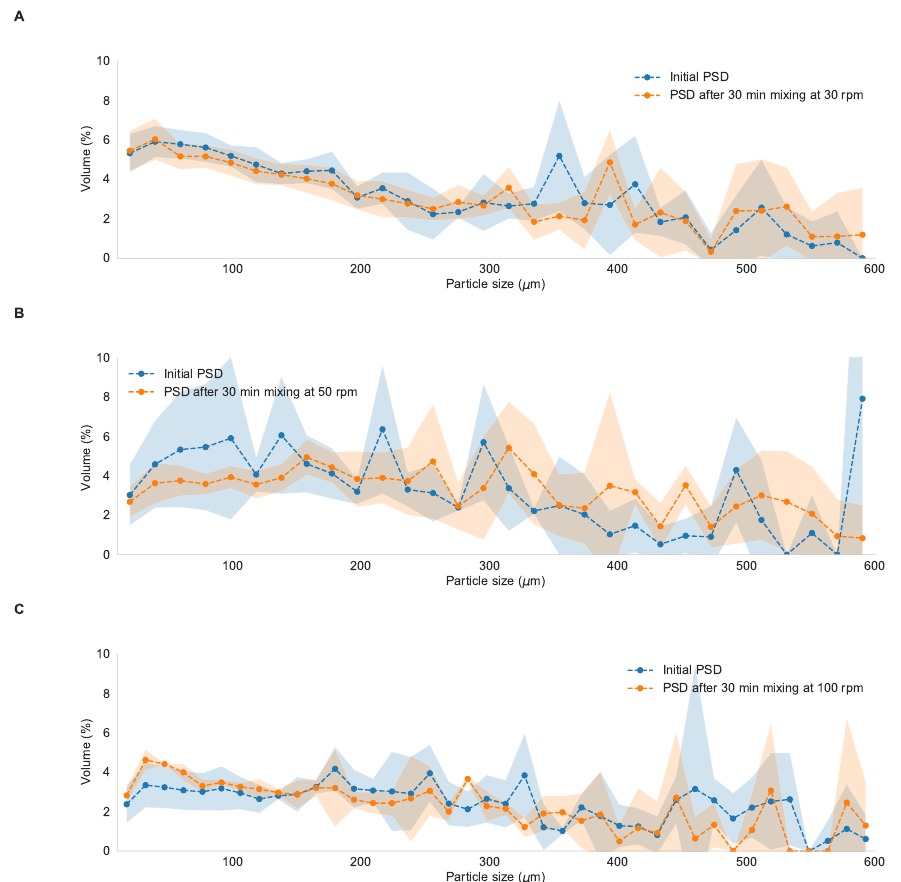
Figure A1. Volume based (in %) particle size distributions (PSDs) of the sludge measured before and after 30 min of mixing (radial mixer) in a square jar, for different mixer speeds: ( A ) 30 rpm, ( B ) 50 rpm, and ( C ) 100 rpm. The standard deviations (SD) on the measurements are given by the shaded area (based on at least three